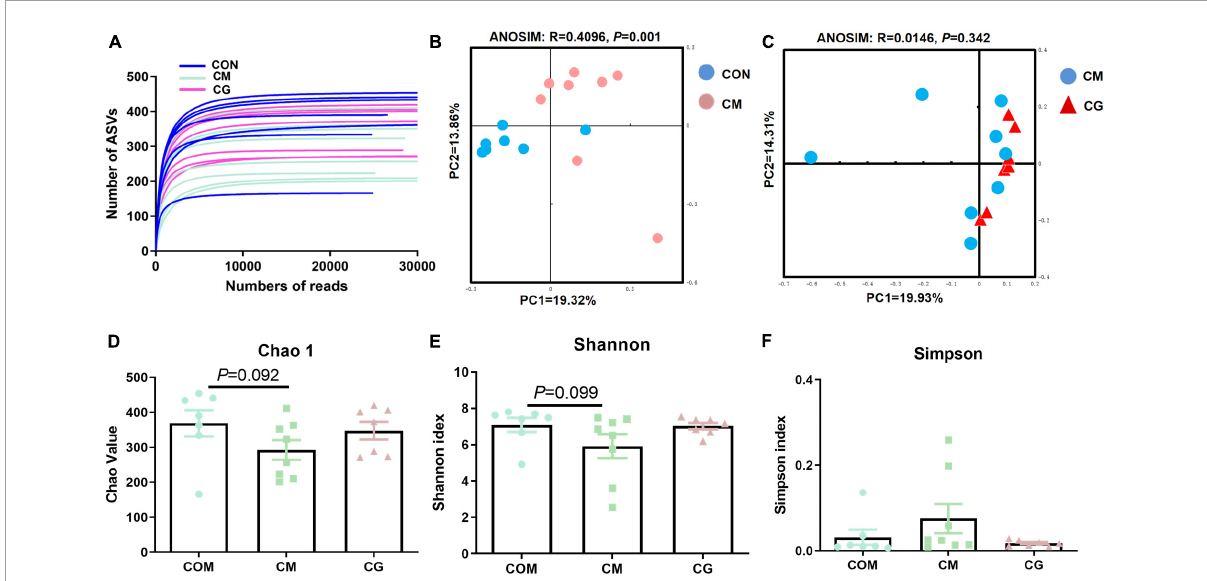
FIGURE2 Effects of low-grain fed (CON), maize meal high-grain fed (CM), and whole maize high-grain fed (CG) on the diversity of colonic content bacterial structures. (A) Bacterial dilution curve of colonic content bacterial community. Horizontal coordinate: the amount of randomly selected sequencing data; vertical coordinate: the number of observed amplicon sequence variants (ASVs). (B) Unweighted UniFrac principal coordinate analysis (PCoA) of bacterial communities in the colonic content between the CON and CM. (C) Unweighted UniFrac principal coordinate analysis (PCoA) of bacterial communities between the CM and CG. Effects of the CON, CM, and CG on the diversity of colonic content bacterial community: Chao1 (D) , Shannon (E) , Simpson (F) .